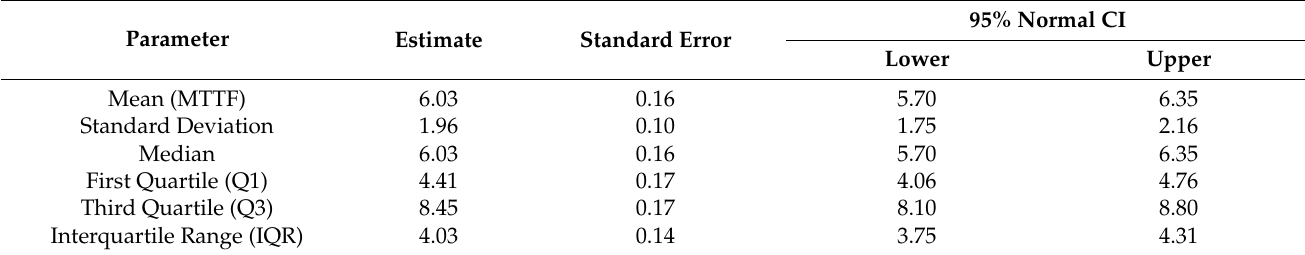
Figure 10. Comparative analysis of the hazard rate functions for the analyzed milling teeth.